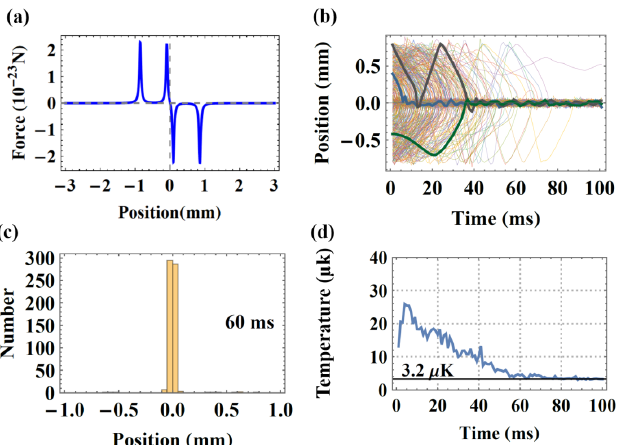
Figure 4. ( a ) Mean radiation force of a dual-frequency, red MOT depending on position of an atom with zero velocity, supposing a µ -gE. The dual-frequency consists of one frequency detuned by ∆ = − 2 π × 200 kHz and one by ∆ = − 2 π × 1.8 MHz. ( b ) Position evolutions of atoms kept 2 1 inside the MOT. Three cures are randomly selected and thickened to be distinguishable. ( c ) Position distribution at the time point of 60 ms. ( d ) Evolution of temperature. The remaining parameters used in this simulation are the same as the ones used in Figure